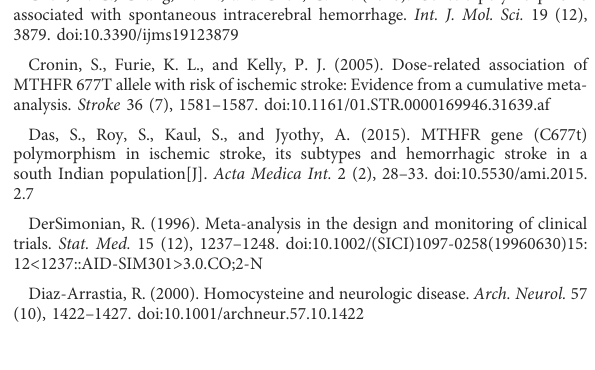
SUPPLEMENTARY FIGURE S1 Forest plot of the association between MTHFR C677T gene polymorphism andtheriskofICHinAsians,Caucasians,andAfricans. (A) Allelemodel(TVSC)inAsians,Caucasians,andAfricans.TandCarethe case group and T1 and C1 are the control group. (B) Recessive gene model (TT VS CC+CT) in Asians, Caucasians, and Africans. where R=CC+CT, R1=CT1+CC1, R and CC are the case group, and R1 and CC1 are the control group. (C) Dominant gene model (TT+CT VS CC) in Asians, Caucasians, and Africans, in which TT and CC are case groups and TT1and CC1 are control groups. (D) Heterozygotegene model (CT VS CC) in Asians, Caucasians, and Africans, in which CT and CC are case groups and CT1 and CC1 are control groups. SUPPLEMENTARY FIGURE S2 Sensitivity analysis of MTHFR C677T polymorphism and risk of ICH in a dominant gene model. SUPPLEMENTARY FIGURE S3 Forest plot of the relationship between MTHFR A1298C gene polymorphism andtheriskofICH. (A) Allelemodel(CVSA),whereCand A are case groups and C1 and A1 are control groups. (B) Homozygous model (CC VS AA), in which CC and AA are case groups and CC1 and AA1 are control groups. (C) Dominant model (CC+AC VS AA), where F=CC+AC, F1=CC1+AC1.F and AA are case groups, and F1 and AA1 are control groups. (D) Recessive model (CCVS AA+AC), where B=AA+AC, B1=AA1+AC1.B, AA is the case group, and B1, AA1 are the control group. (E) Heterozygousmodel(ACVSAA),inwhichACandAAarecase groups and AC1 and AA1 are control groups. SUPPLEMENTARY FIGURE S4 The Begg funnel plot of the relationship between MTHFR A1298C gene polymorphism and the risk of ICH. SUPPLEMENTARY TABLE S1 Differences between other meta-analyses similar to this